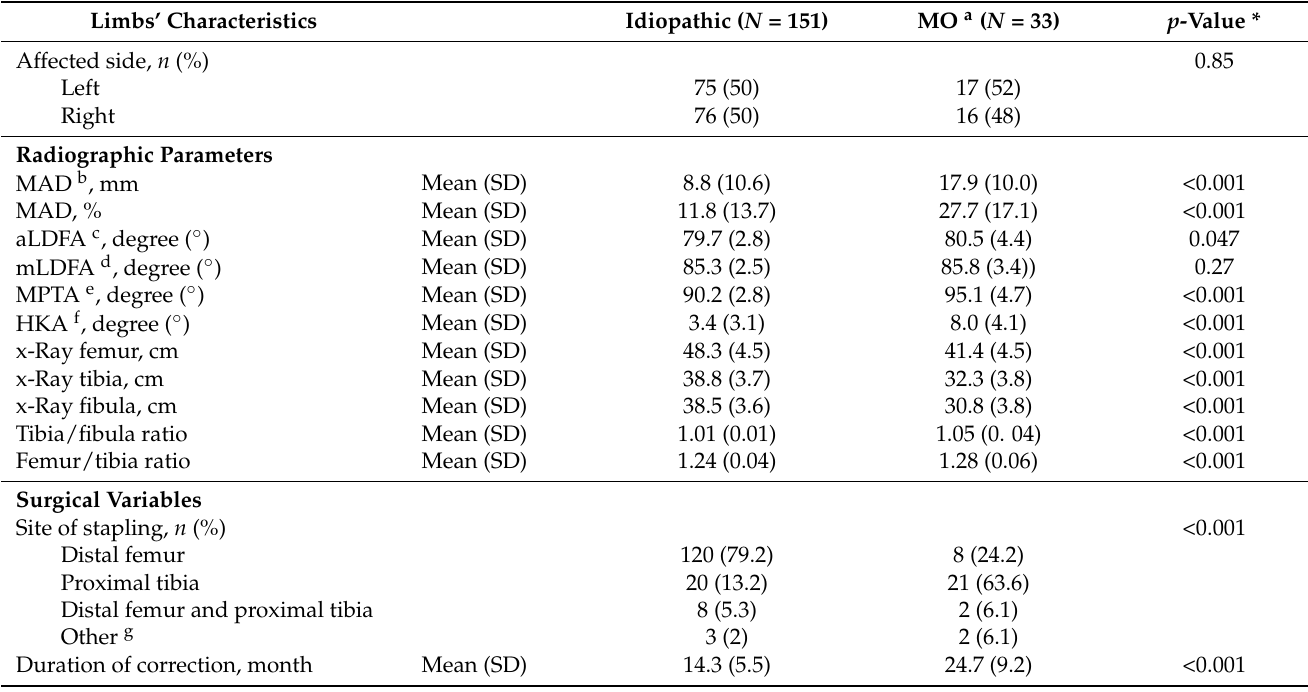
Table 2. Limbs’ characteristics at baseline evaluation.